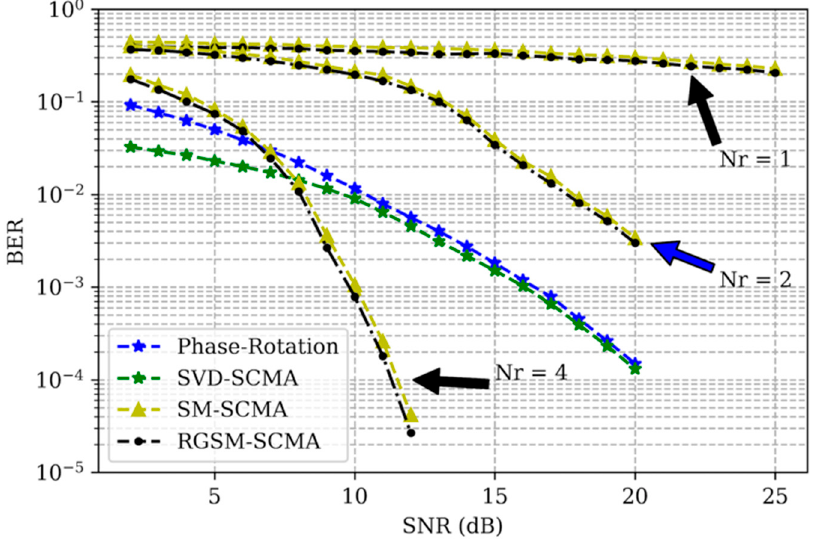
Figure 7. BER performance comparison.